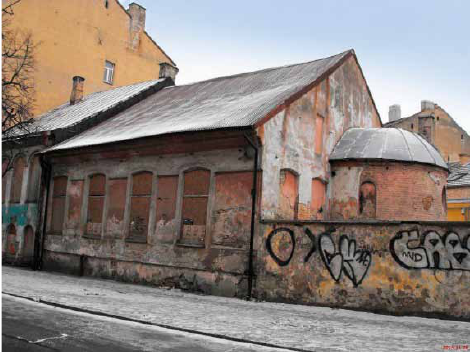
Fig. 3. Vilnius synagogue, Gėlių